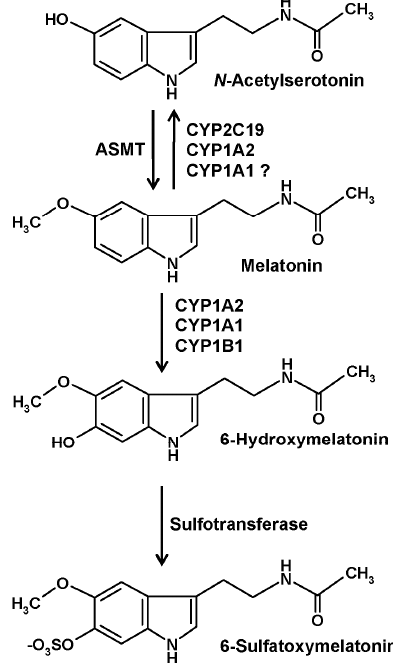
Figure 1. The main catabolic route of circulating melatonin in vertebrates. Abbreviations: ASMT, N -acetylserotonin O -methyltransferase (formerly known as hydroxyindole O -methyltransferase, HIOMT); CYP, cytochrome P 450 . Hydroxylation and demethylation reactions by CYP isoforms, as indicated, are not only known from liver, but also from the brain [1]. Nonenzymatic formation of 6-hydroxymelatonin by free radicals is also chemically possible, but of minor importance relative to the CYP-dependent pathway.